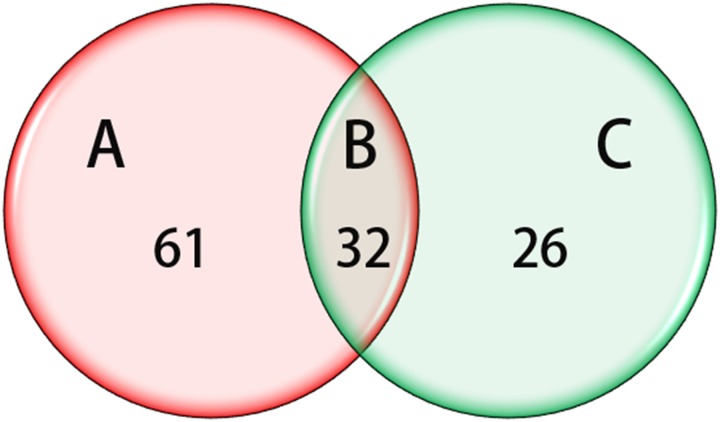
miRNAs that are Dysregulated in cancer correlated with cancer differentiation.(A) Compared with normal tissues, a total of 93 miRNAs that were significantly dysregulated were identified, (B) 58 dysregulated miRNAs were found in moderately differentiated tissues compared with well-differentiated tissues, (C) 32 miRNAs were not only able to identify cancers samples and normal controls, but they were also able to distinguish between well- and moderately differentiated tumors.